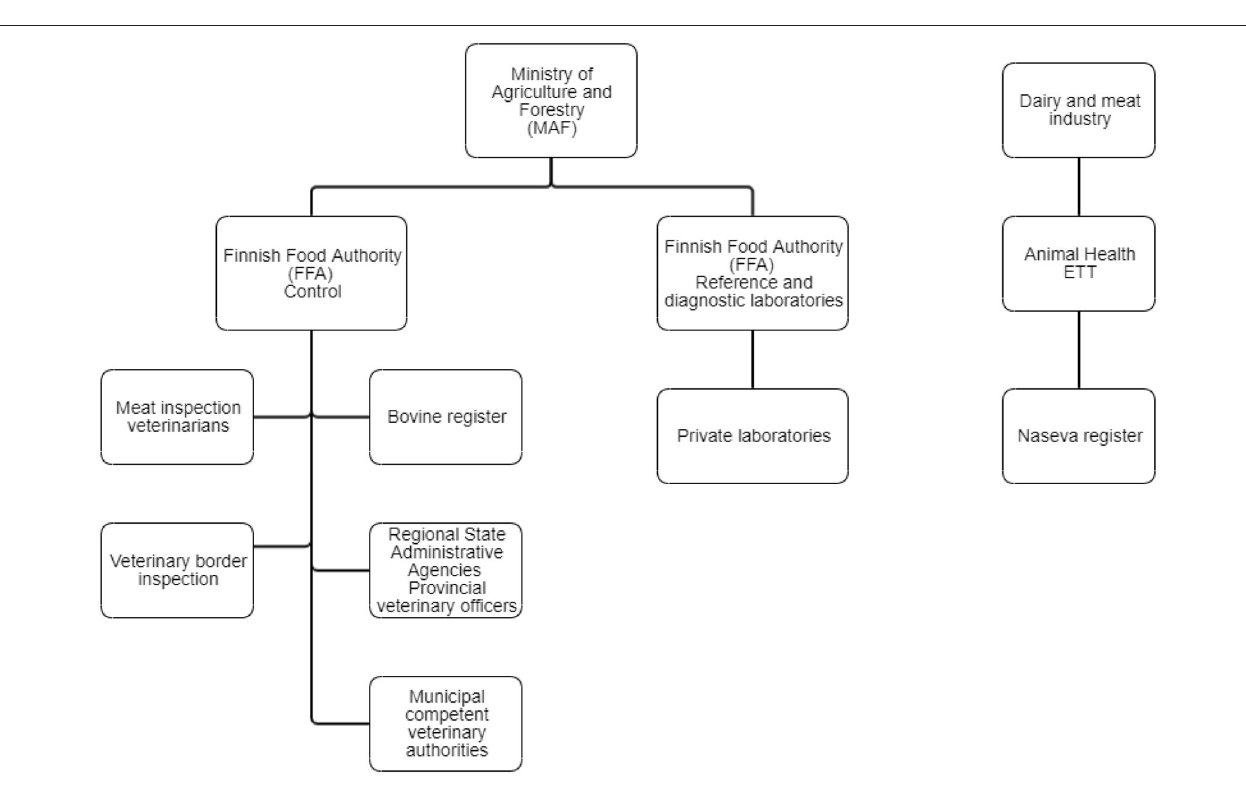
FIGURE 2 | Organizations involved in cattle disease control in Finland. The Naseva register has several interfaces to databases and different computer systems, e.g., the Bovine Register, mastitis testing laboratories, the Finnish Dairy Herd Recording System, meat inspection databases of slaughterhouses, and the veterinary practice management